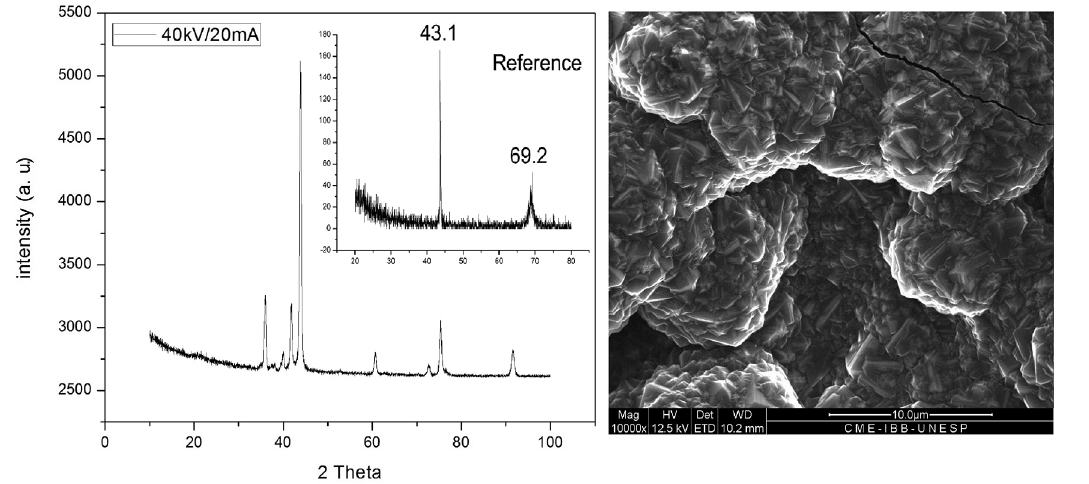
Figure 6. X-ray diffraction spectra obtained from the coating (external) and a natural diamond (internal). Some additional peaks at 35°, 39°, 41°, 60°, 72°, 76° and 91°indicate the distortions in the crystal lattice, which may explain the high internal stress of the coating. Some spots of cracks were identified in the sample and can be seen on the image of the spectra.